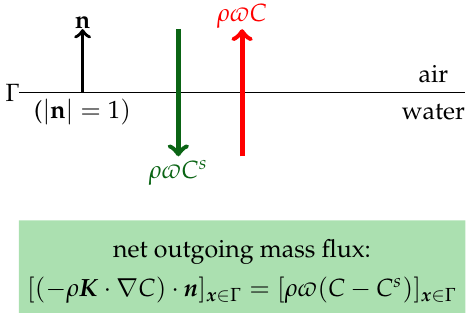
Figure 7. Illustration of the gas fluxes (kg m − 2 s − 1 ) involved in boundary condition (53). The net gas (mass) flux through the water–air interface, which is positive in the upward direction (that is, from = [ ρ(cid:118) C ] water to air), is the difference between the outgoing flux, ρφ ↑ x ∈ Γ , and the incoming one, C s is the surface concentration in equilibrium with the = [ ρ(cid:118) C s ] ρφ ↓ x ∈ Γ , where C C